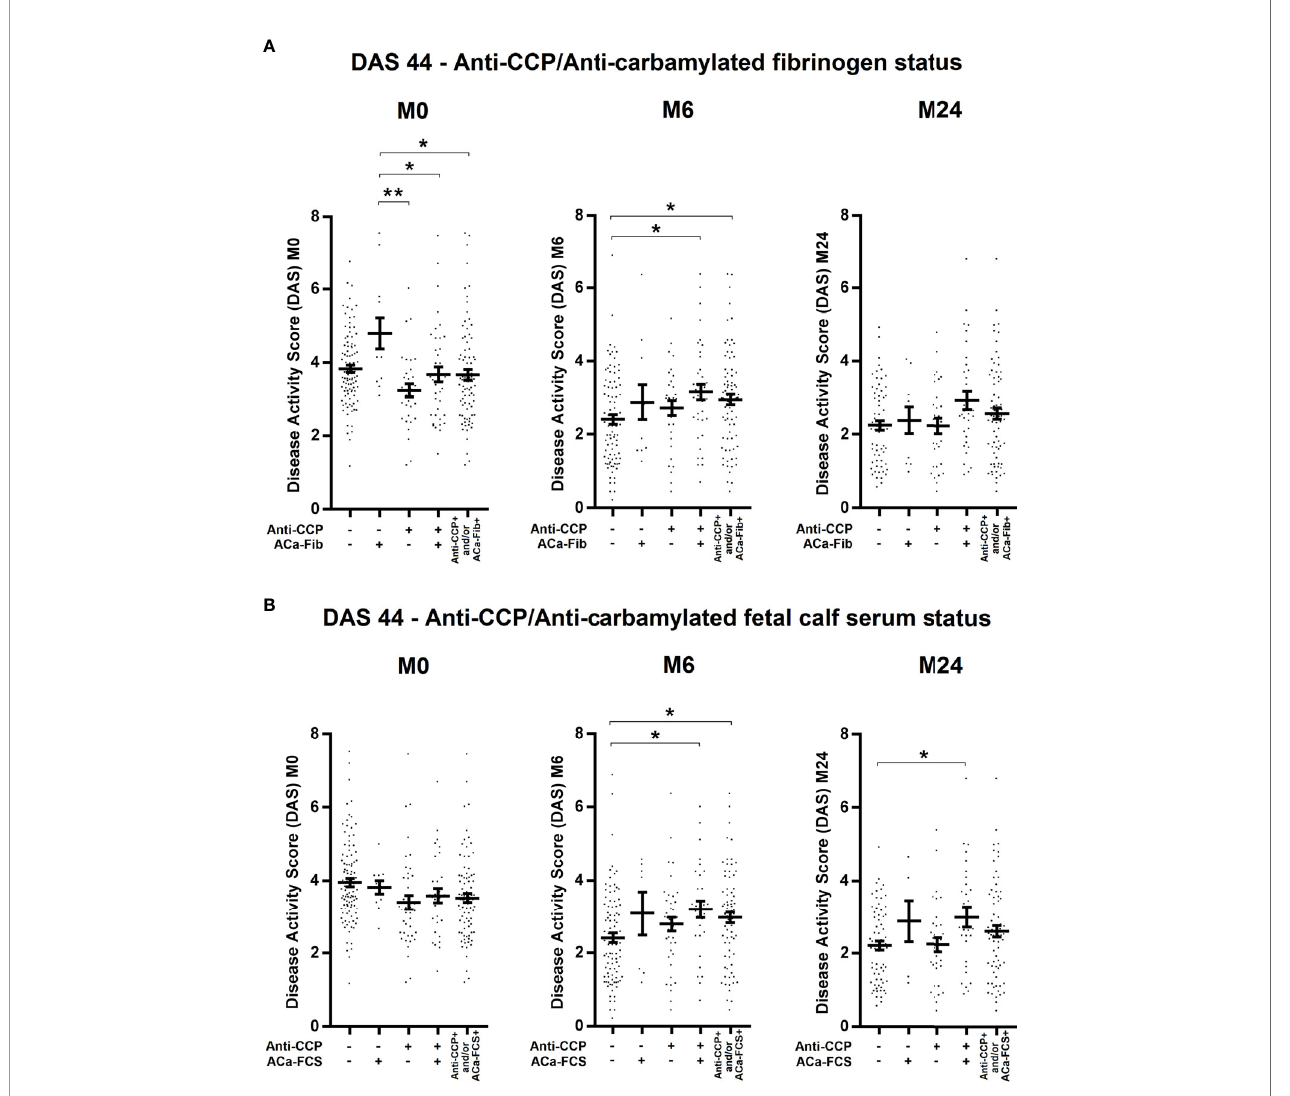
FIGURE 5 | Evolution of disease activity of RA patients atbaseline, 6 months, and2 yearsaccordingto anti-CCP antibodies andACa-Fib statusor ACa-FCS status. Disease Activity Score (DAS)44 of RA patients according to (A) Anti-CCP/ACa-Fibstatusor (B) Anti-CCP/ACa-FCS status at baseline (M0),6 months(M6), and 2 years (M24).Averages with SEM are shown.Groups comparedusing one-way ANOVA and Tukey post-test, *p-value<0.05, **p-value<0.01. Anti-CCP, anti-cyclic citrullinated peptide antibodies; ACa-Fib,anti-carbamylated fi brinogen antibodies; ACa-FCS, anti-carbamylated fetalcalfserum